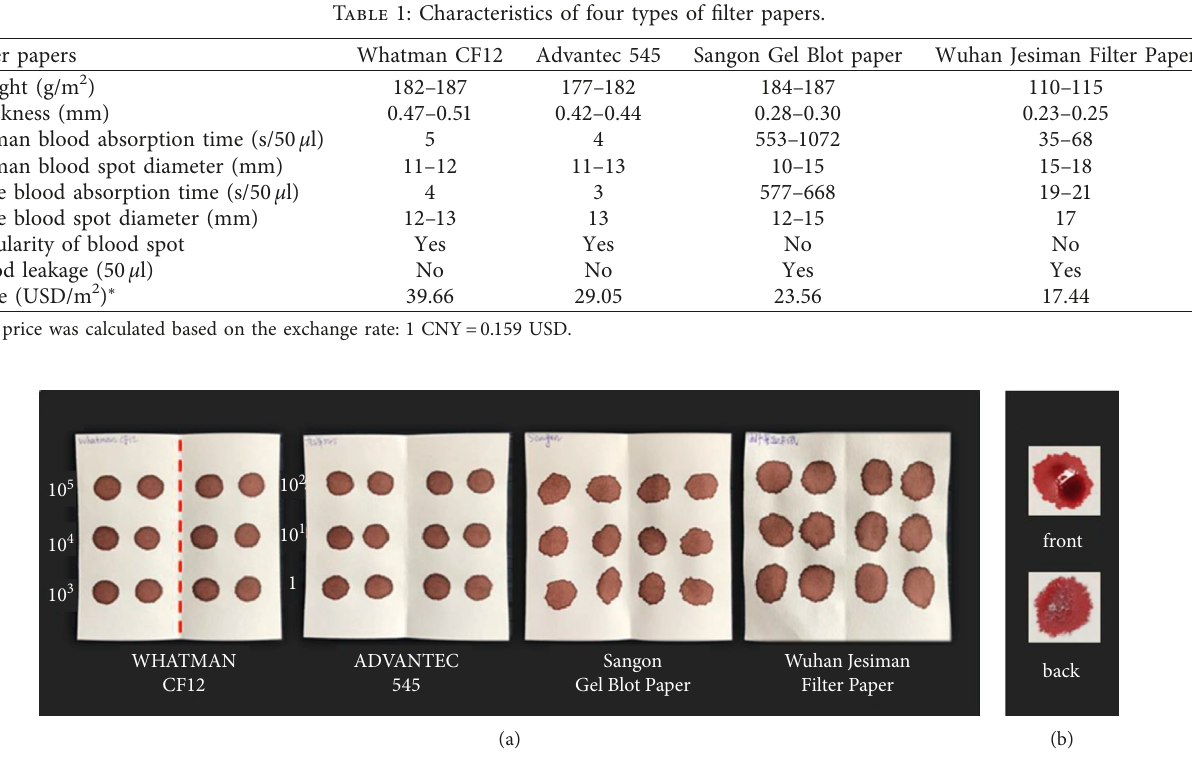
Figure 2: Dried blood spots formed by four filter papers after absorbing serial diluted Plasmodium -infected blood: (a) the shape of dried blood spots formed on four types of filter papers and (b) the leakage of blood during the formation of blood spots.